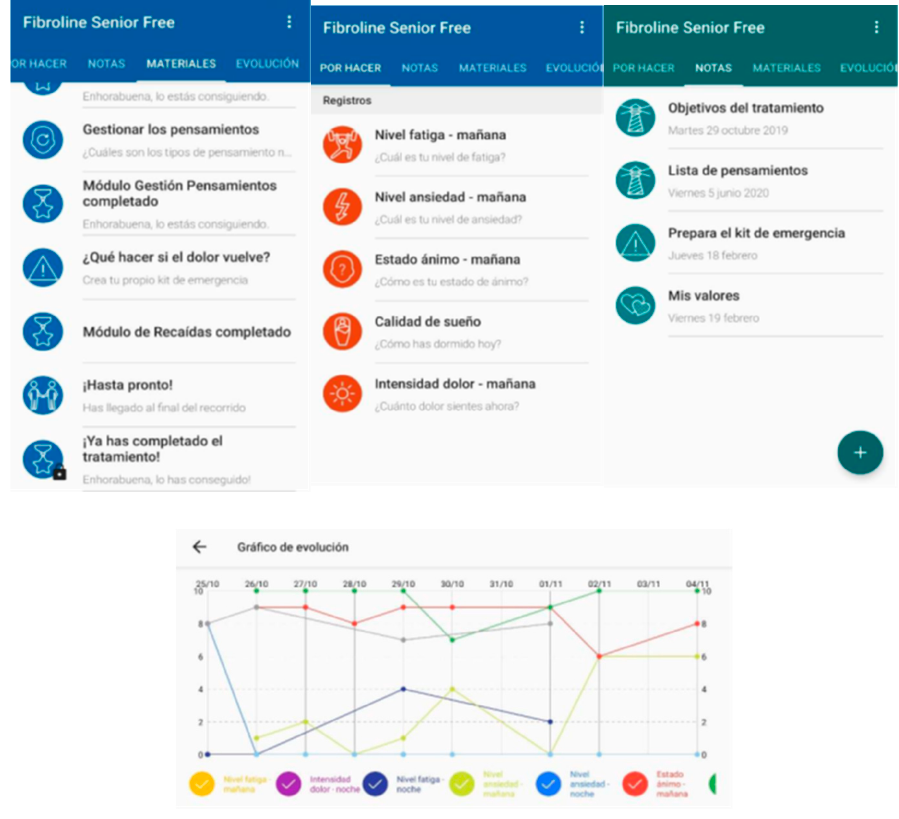
Figure 1. Samples of different screen snapshots from Fibroline.